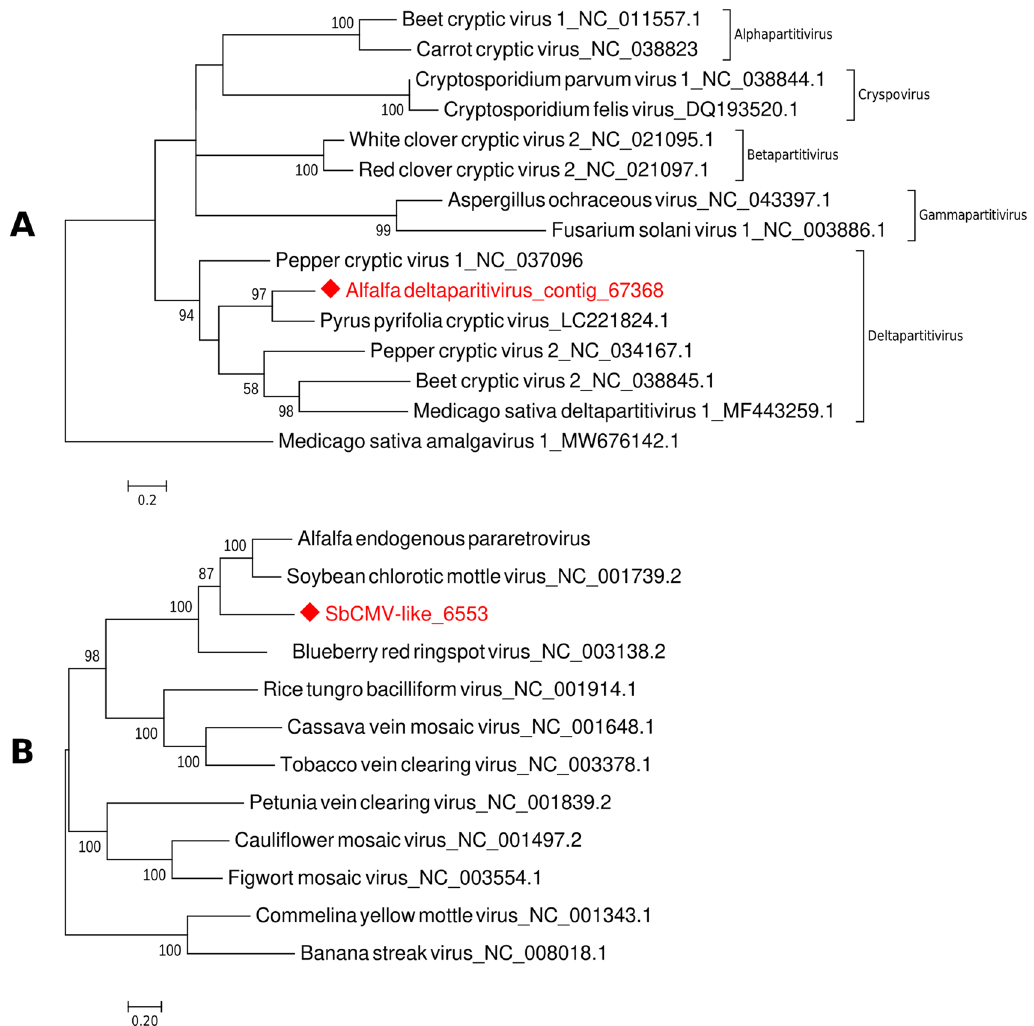
Figure 6. Phylogenetic analysis of the newly identified alfalfa deltaparitivirus (ADPV) found in alfalfa samples collected from production fields in the U.S. Pacific Northwest in 2019/2020, and endogenous virus resembling soybean chlorotic mottle virus (SbCMV-like). ( A ) The phylogenetic tree was deduced from the ClustalW alignment of the proposed ADPV with the complete nucleotide sequences of the representative members of the family Partitiviridae . Medicago sativa amalgavirus 1 (MW676142.1) was used as an outgroup. ( B ) The phylogenetic tree was deduced from the ClustalW alignment of the SbCMVL with the complete nucleotide sequences of the representative species from each genus of the family Caulimoviridae. The trees were built using MEGA 7 software with Maximum Likelihood method based on the Tamura-Nei model and bootstrap analysis of 1000